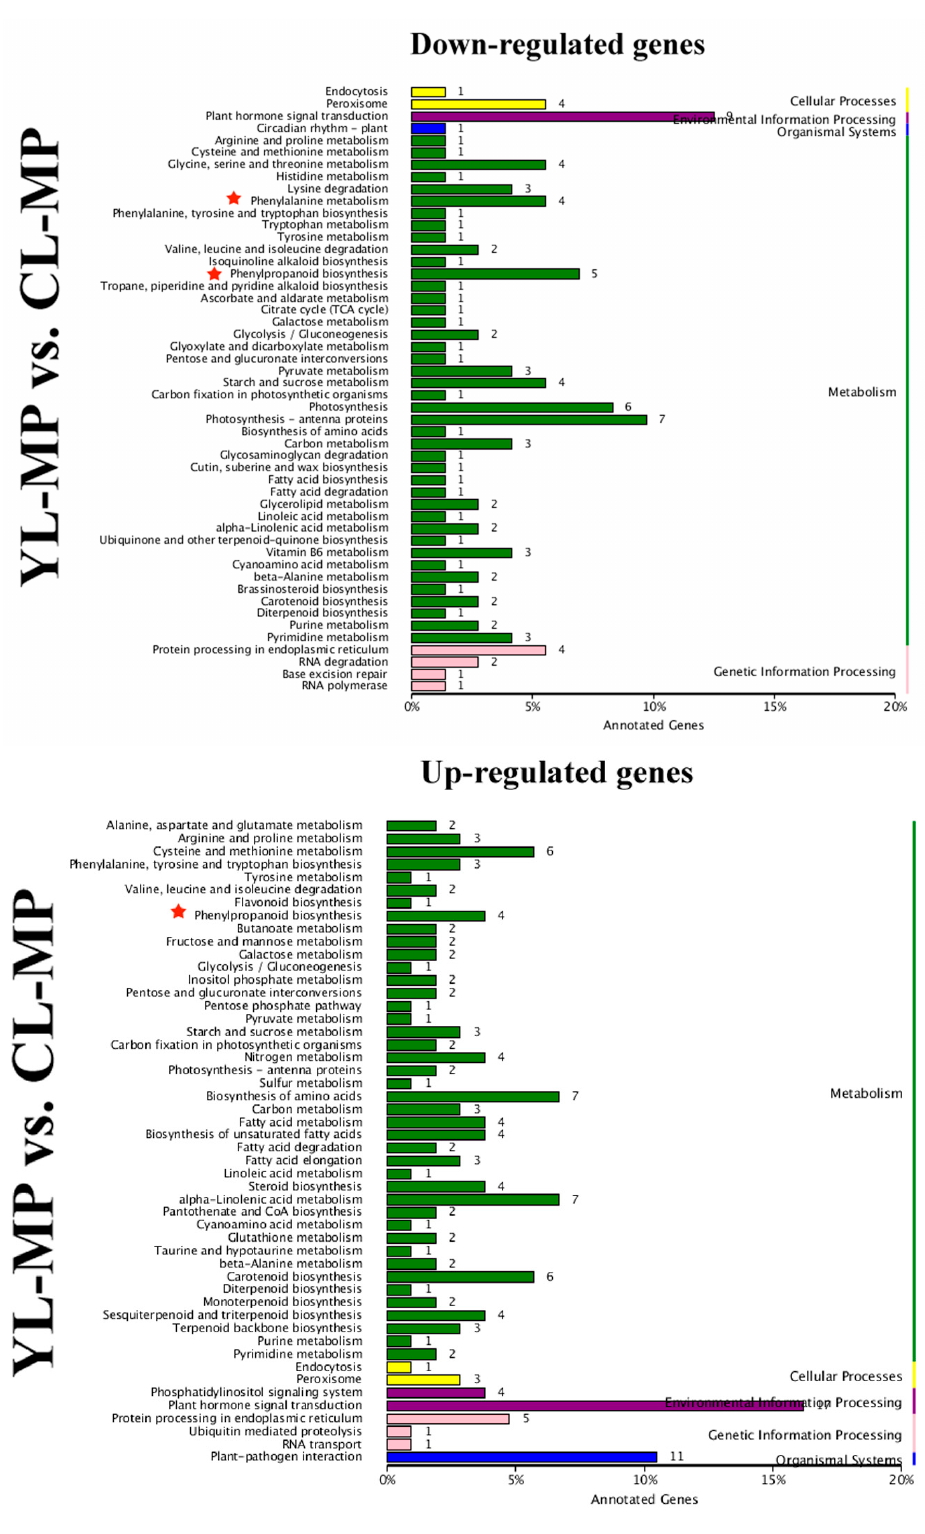
Figure 5. Kyoto Encyclopedia of Genes and Genomes (KEGG) classification maps of di ff erentially expressed genes. The ordinate represents the name of the KEGG metabolic pathway. The abscissa represents the proportion of genes in a metabolic pathway to the total number of annotated genes. Phenylpropanoid biosynthesis and phenylalanine metabolism are marked with an asterisk because they are closely related to lignin metabolism. Up-regulated genes in A_vs._B: genes whose expression level in sample B is higher than that in sample A; otherwise they are down-regulated